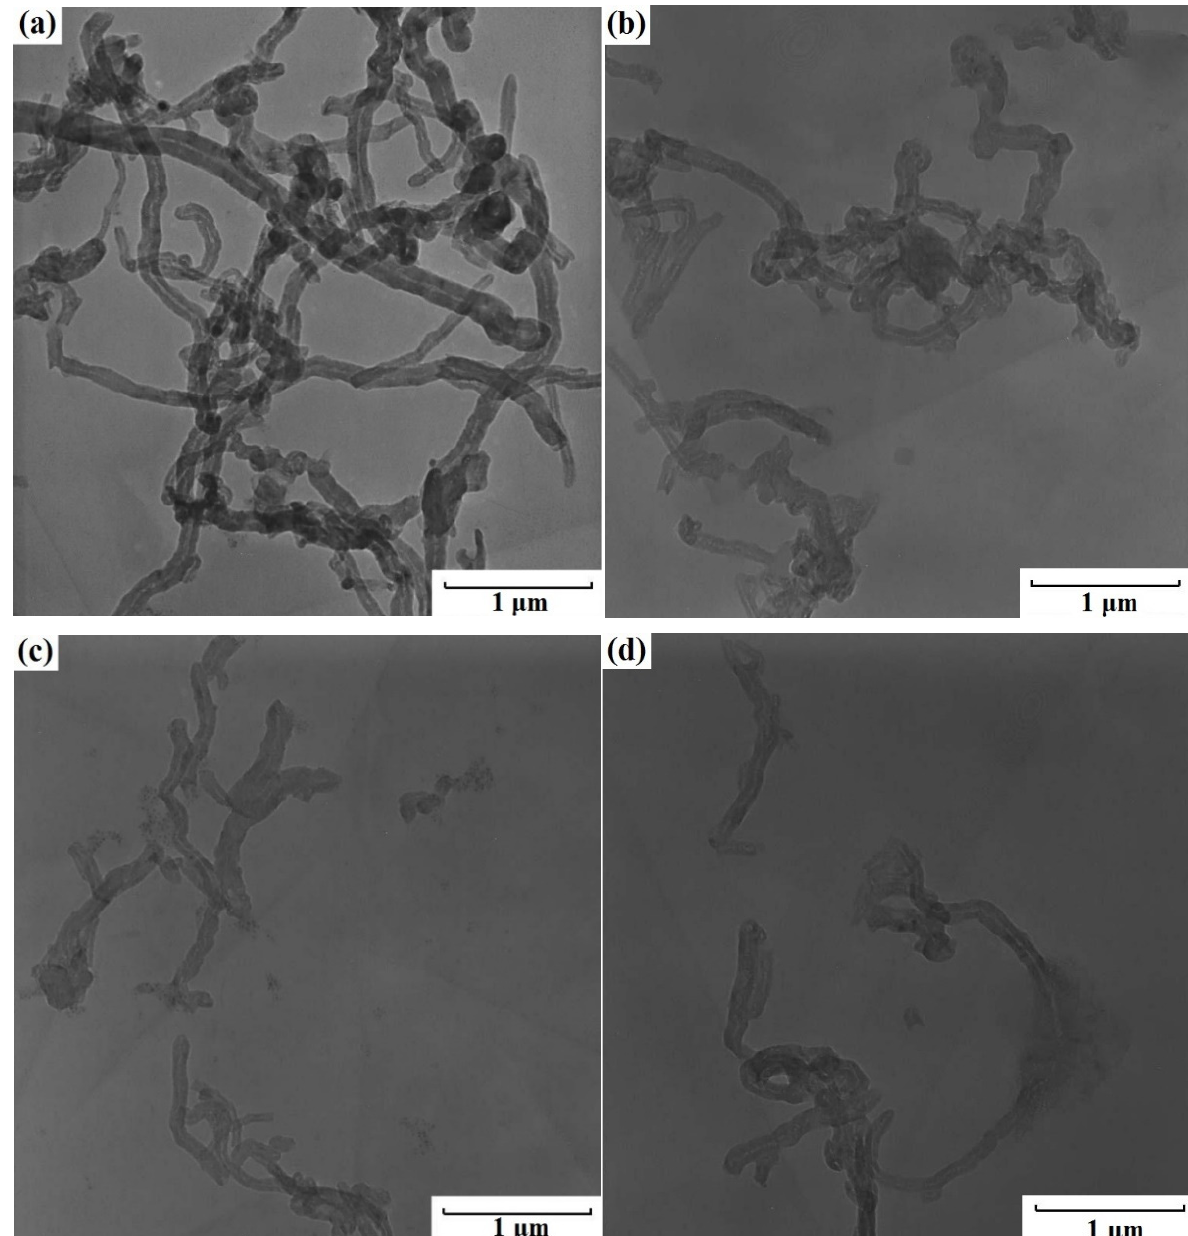
Figure 2. The TEM images of the MWNT forms: ( a ) raw MWNT; ( b ) oxidized MWNT; ( c ) MWNT-1; and ( d ) MWNT-2.